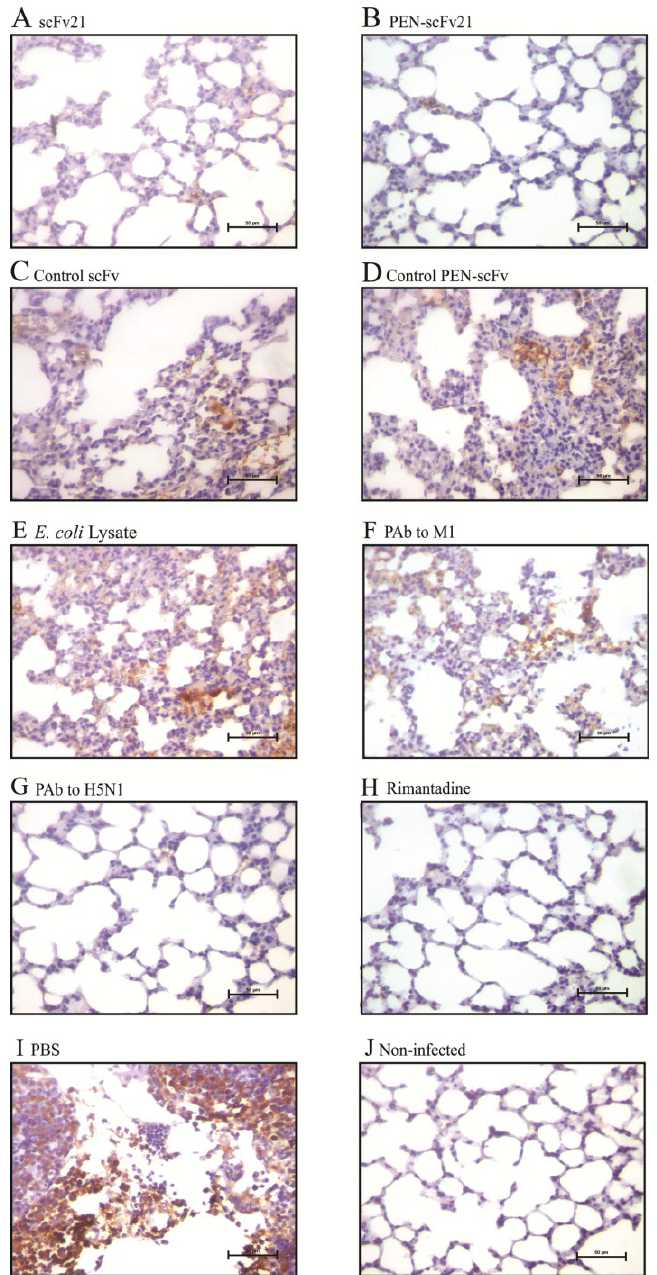
Figure 7. Immunohistochemical staining for influenza virus nucleoprotein (brownish gold pigments) in lung sections (40× original magnification) of mice infected with 10 MLD 50 of mouse adapted A/chicken/Thailand/NP-172/2006 (H5N1), clade 2, subclade 3 at 96 h post infection. ( A – H ) Infected mice treated with 10 mg/kg body weight of scFv21, PEN-scFv21, control scFv, control PEN-scFv, E. coli lysate, PAb to M1, PAb to H5N1 and rimantadine; ( I ) Infected mouse treated with PBS and ( J ) normal